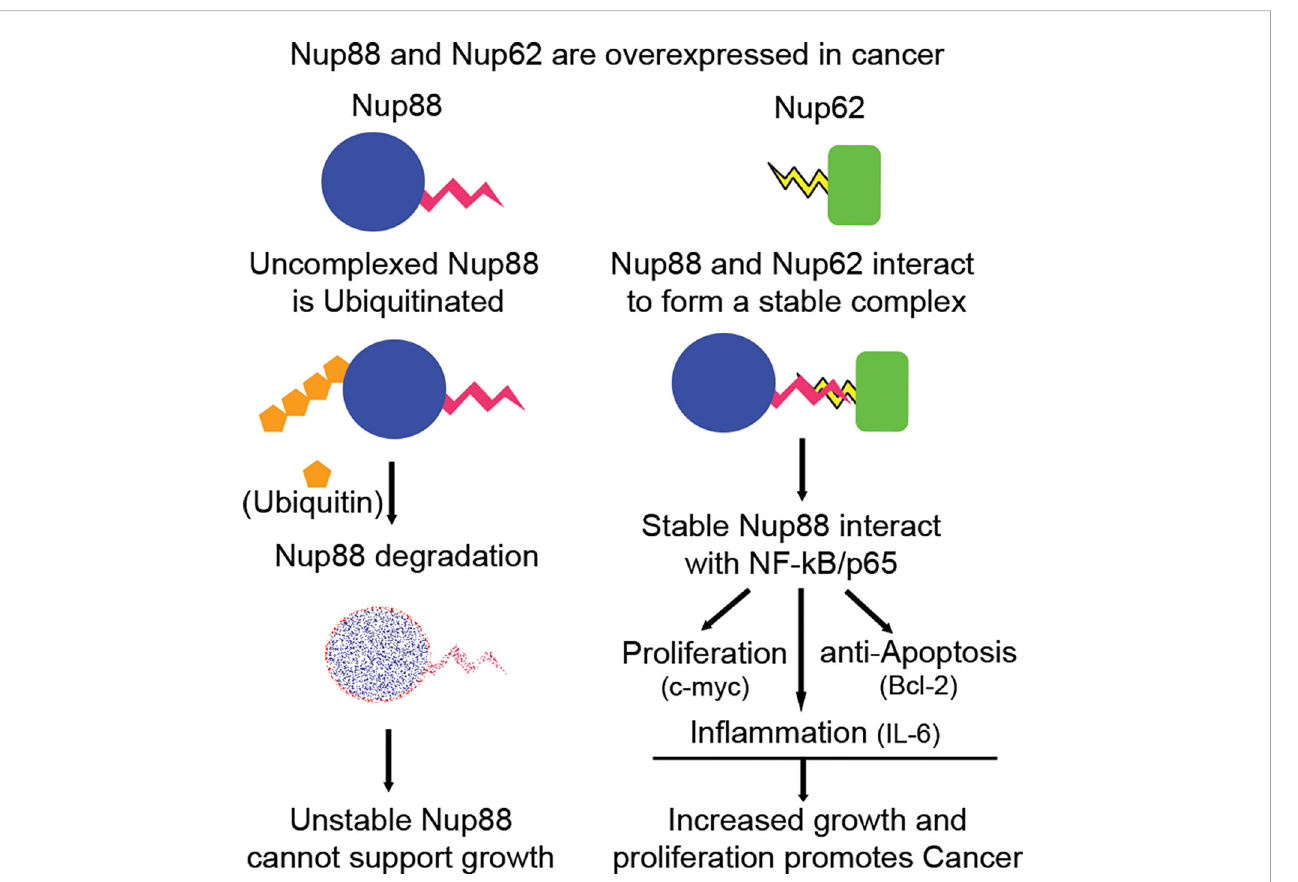
FIGURE 7 Nup88 in complex with Nup62 is stable and affects growth, proliferation and survival arm of NF- k B pathway in cancer. Nup88 and Nup62 are overexpressed in cancer, including head and neck cancer. Excess Nup88 in these cancer tissues can be targeted for degradation by ubiquitin-mediated proteasomal pathway, whereas Nup88 when complexed with co-expressed Nup62 in these tissues is stable. Stabilized Nup88 interacts with p65 and sequesters active p65 inside the nucleus. The extended presence of p65 inside the nucleus under Nup88 overexpressing conditions promotes the expression of target genes like c-myc, Bcl2, and IL-6 to simultaneously regulate growth, proliferation, apoptosis, and in fl ammation driving